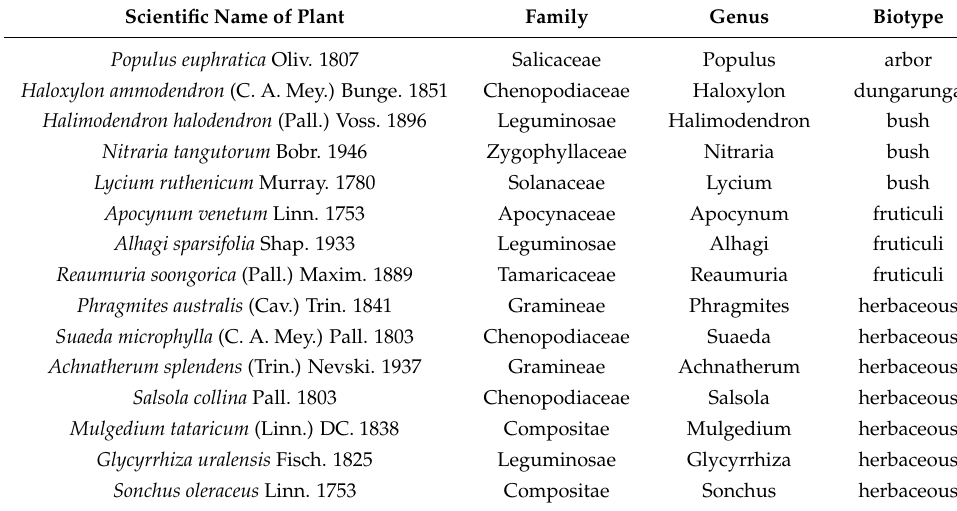
Table 1. List of plants in the sample plots at the Ebinur Lake Basin. Scientific Name of Plant